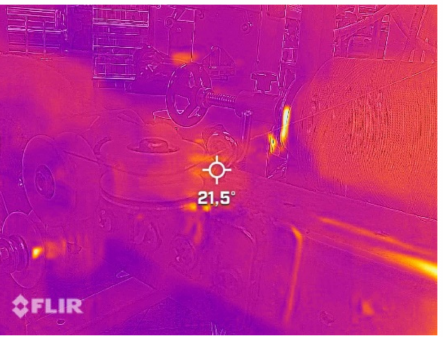
Figure 3. Measuring paper yarn temperature during the application of finishing materials using an infrared